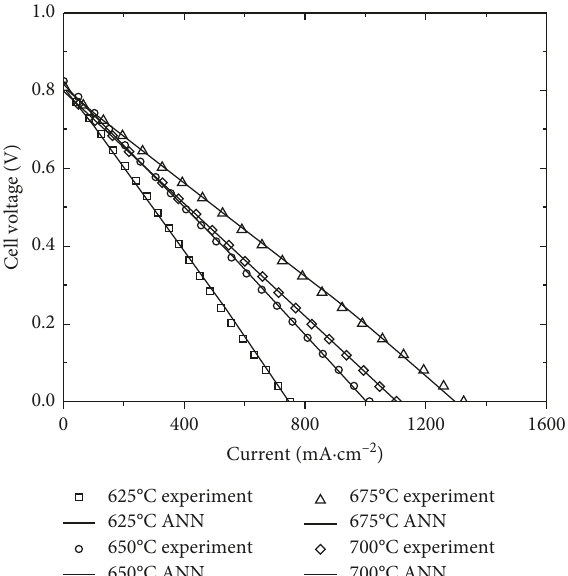
Figure 7: Comparison of I - V curves for the cathode sintered at 1025 ° C and operated at different temperatures by the ANN model and experimental